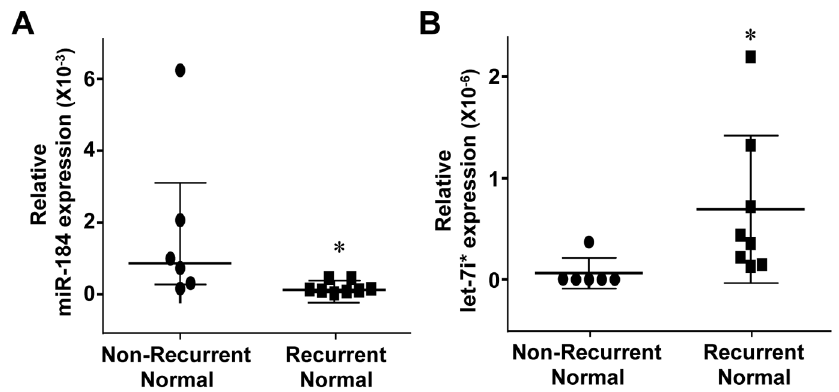
Figure 3. Validation of reduced miR-34b and miR-106b* levels in stage I lung adenocarcinoma and normal adjacent lung tissue. miR-34b and miR-106b* expression was measured using TaqMan qRT-PCR in a second cohort of stage I lung adenocarcinoma and adjacent normal lung tissue. D Ct values graphed are relative to the endogenous small RNA control RNU48 with SEM. (A) Mean relative D Ct value of tumors that did and did not relapse (n=8) compared to mean value of adjacent normal lung tissues for both tumors (n=7), *p=0.03. (B) Mean relative D Ct values of recurrent lung adenocarcinoma (n=3) or adjacent normal lung tissue (n=3), *p=0.02. (C) Mean relative D Ct values in tumors that did (n=3) or did not (n=5) relapse, *p=0.02. (D) Mean relative D Ct values of adjacent normal lung tissue from patients that did (n=3) or did not relapse (n=4), *p=0.05. All p values calculated by student’s t-test.